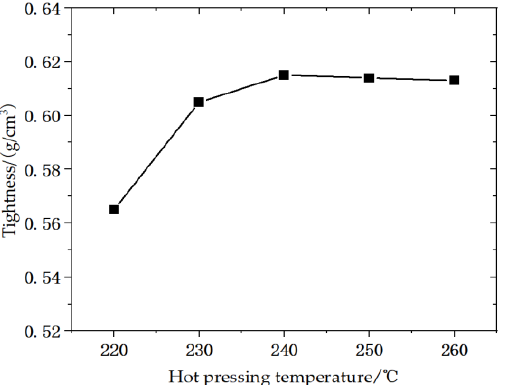
Figure 1. Tightness of insulating paper with different hot pressing temperatures.